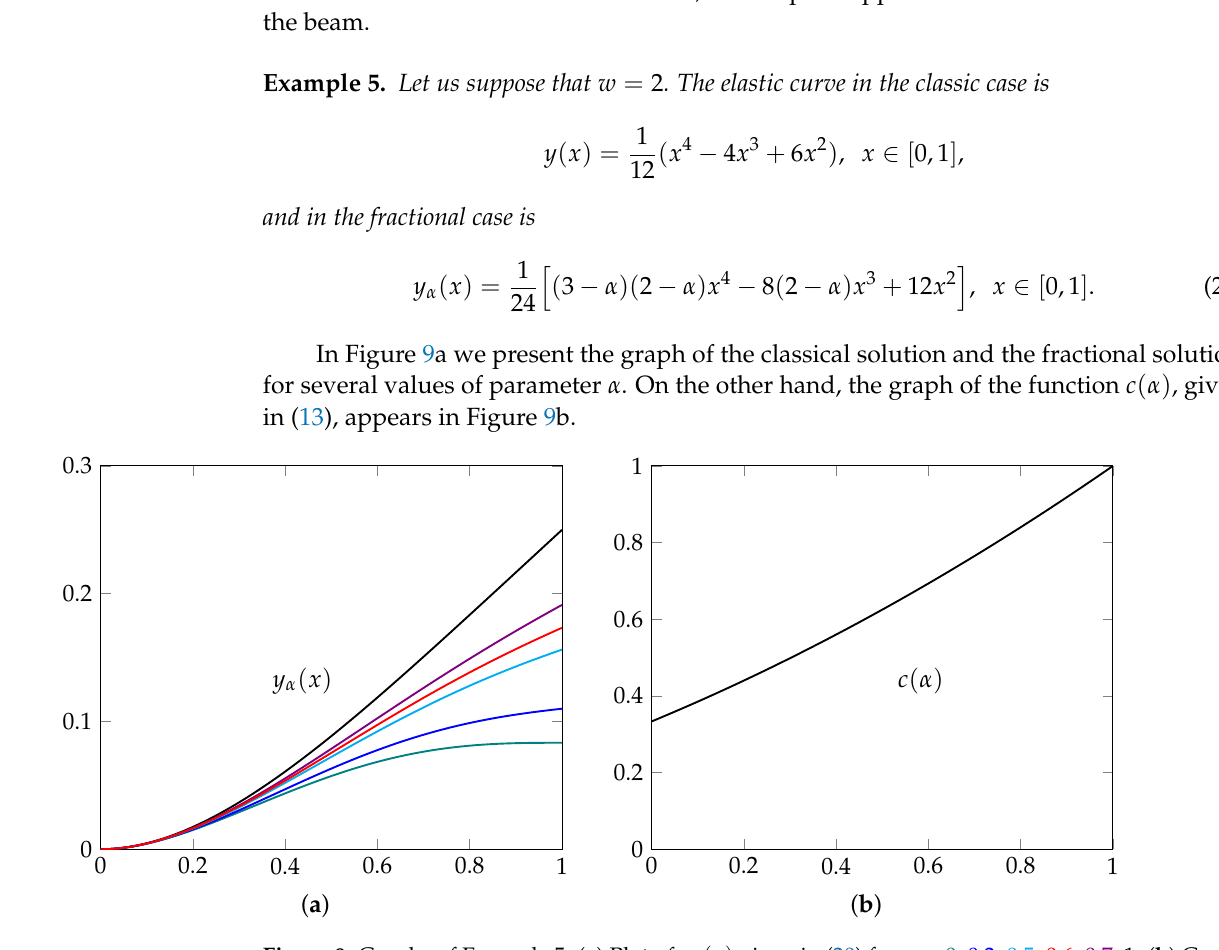
Figure 9. Graphs of Example 5. ( a ) Plot of y α ( x ) given in (20) for α = 0, 0.2, 0.5, 0.6, 0.7, 1. ( b ) Graph of c ( α ) given in